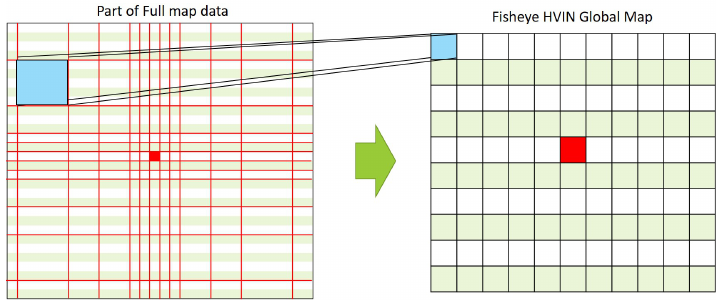
Figure 7. Proposed Fisheye HVIN